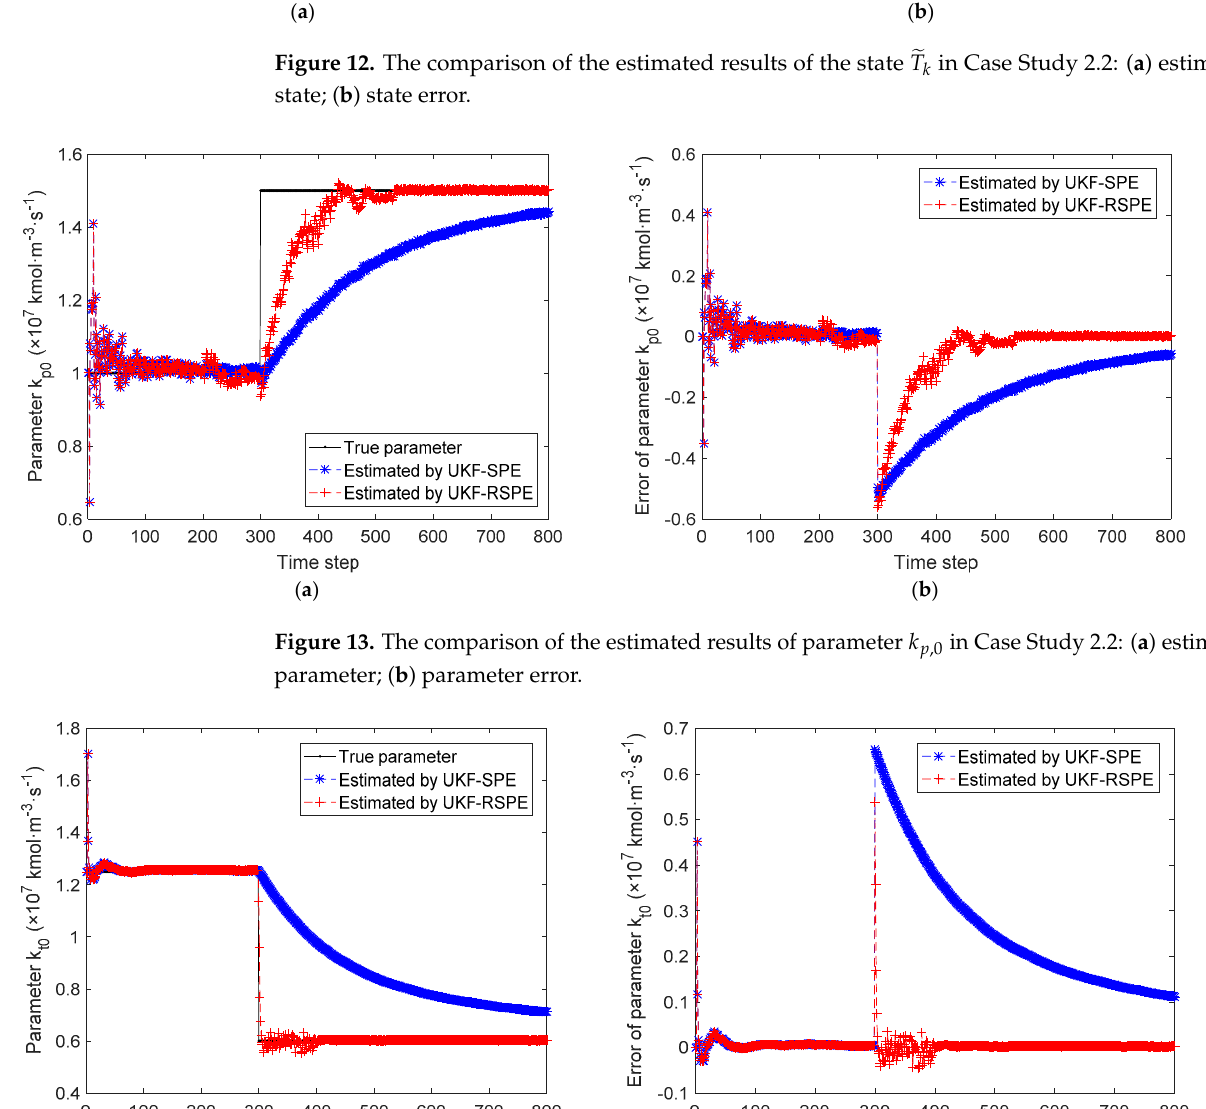
T  in Case Study 2.2: ( a ) estimated k